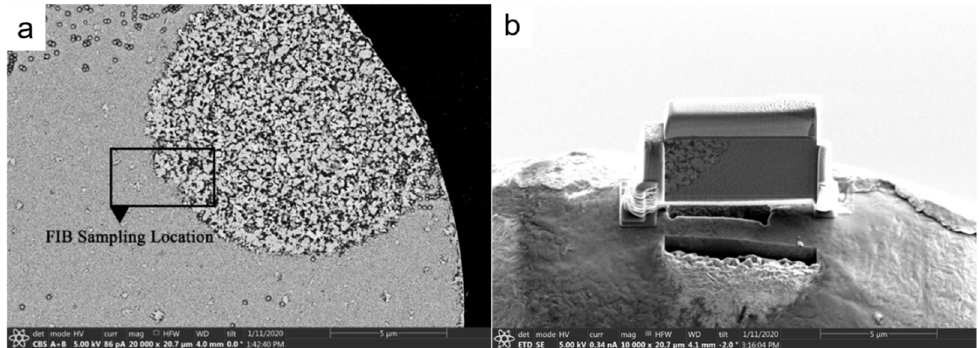
Figure 7. TEM sample image of Fe-W-B amorphous powder annealed at 700 °C. ( a ) FIB sampling location image; ( b ) FIB sample